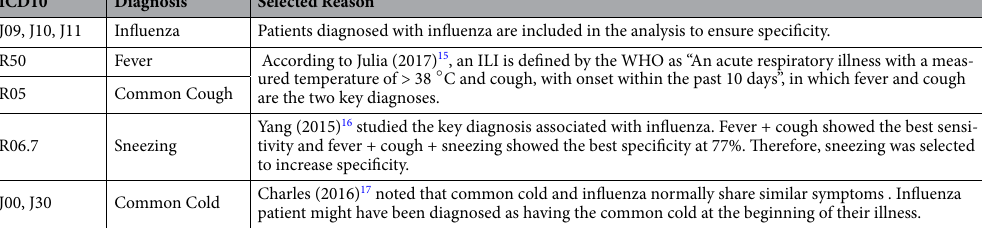
Table 1. ICD10 Code and ILI